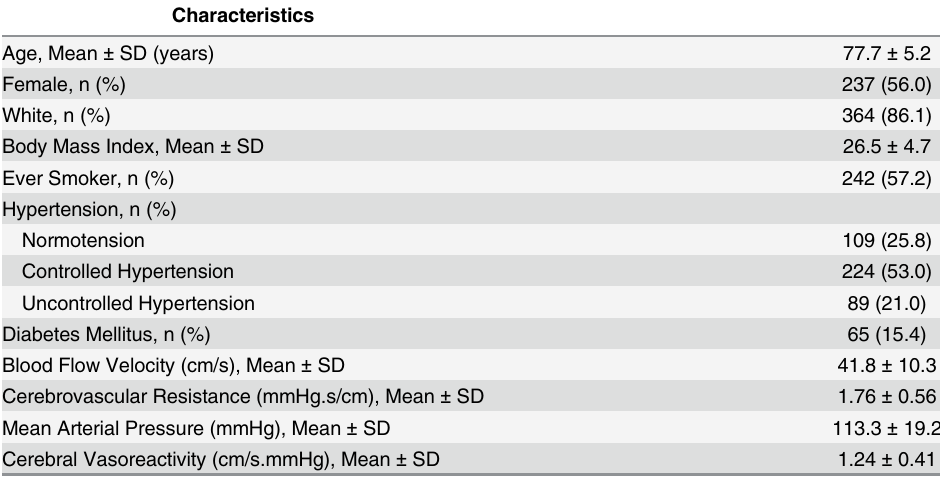
Table 1. Characteristics of 423 Participants from the MOBILIZE Boston Study.